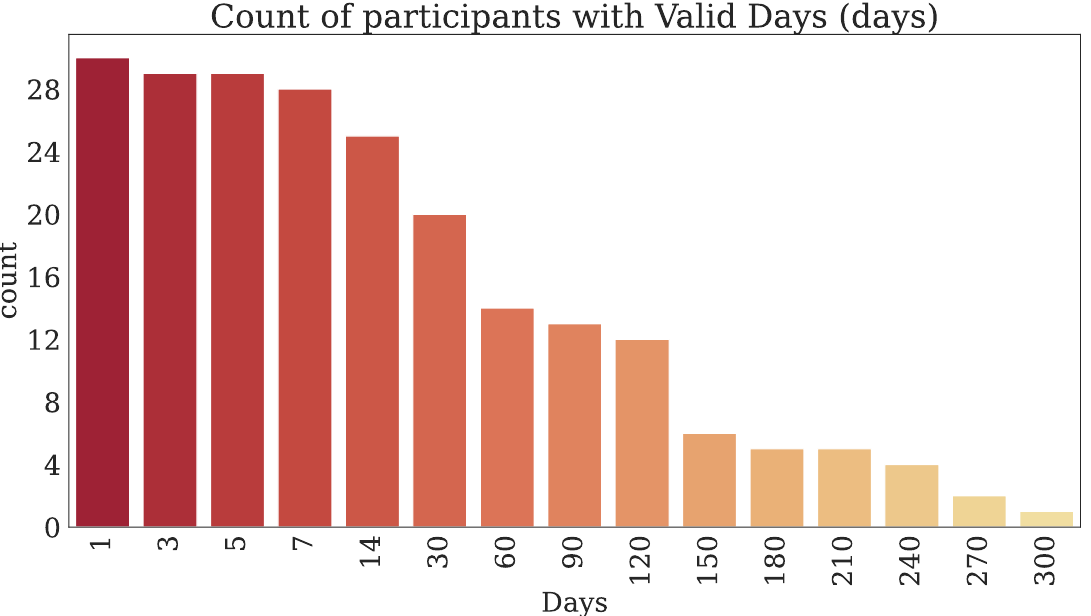
Figure 5. Count of seniors with at least the given valid days of Fitbit (TechRO)